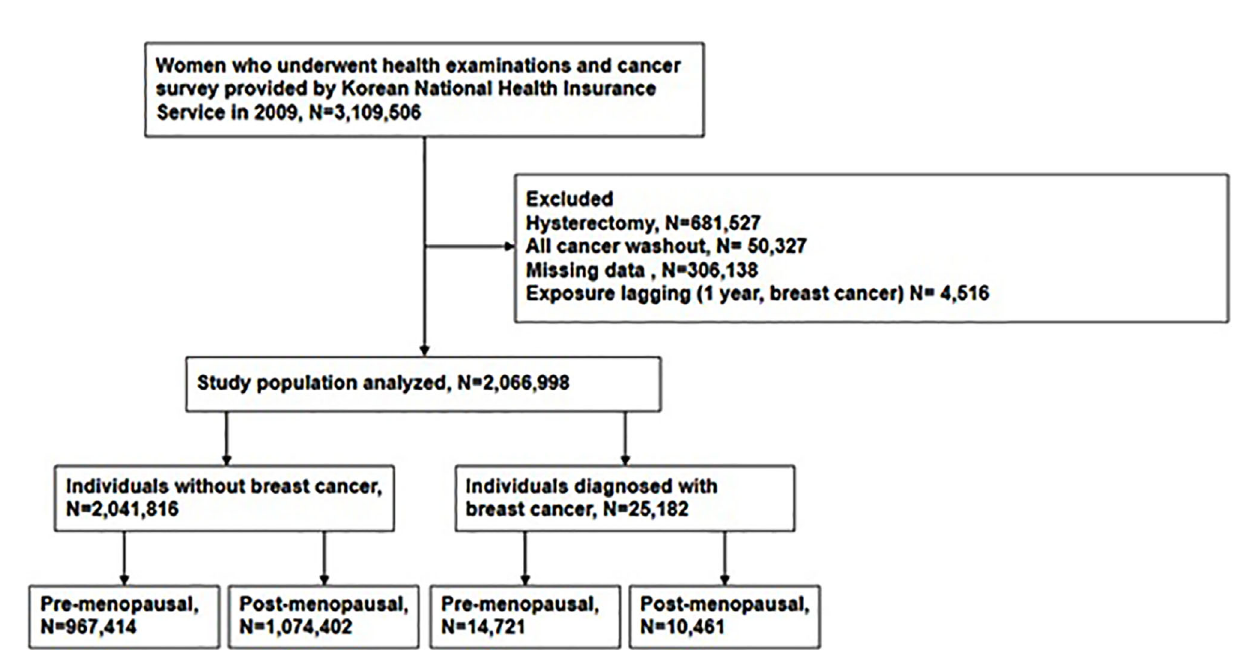
FIGURE 1 | Flow chart depicting the design of the study participants by Korean National Health Insurances